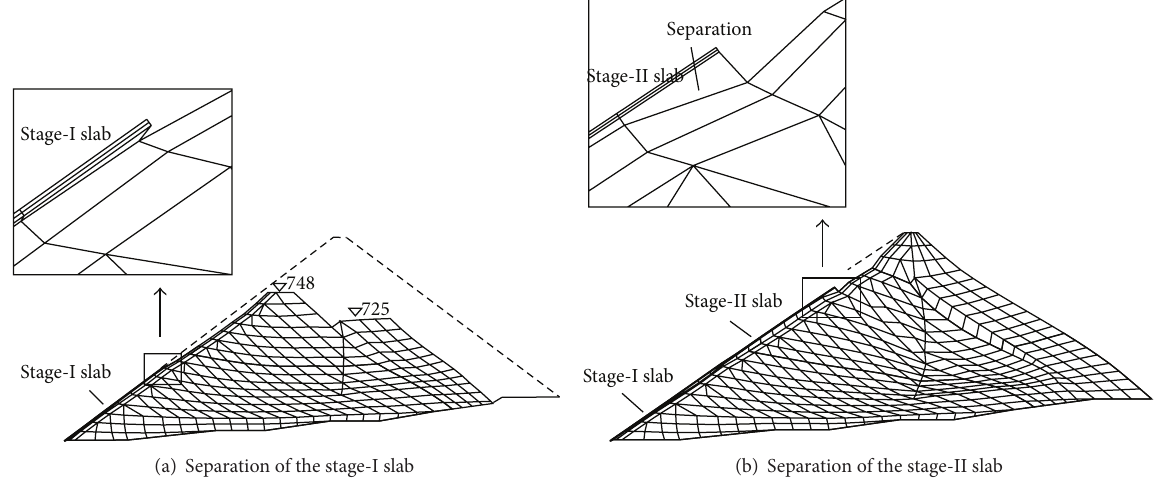
Figure 11: Separation of the slab from the cushion layer at different stages (interface element method).